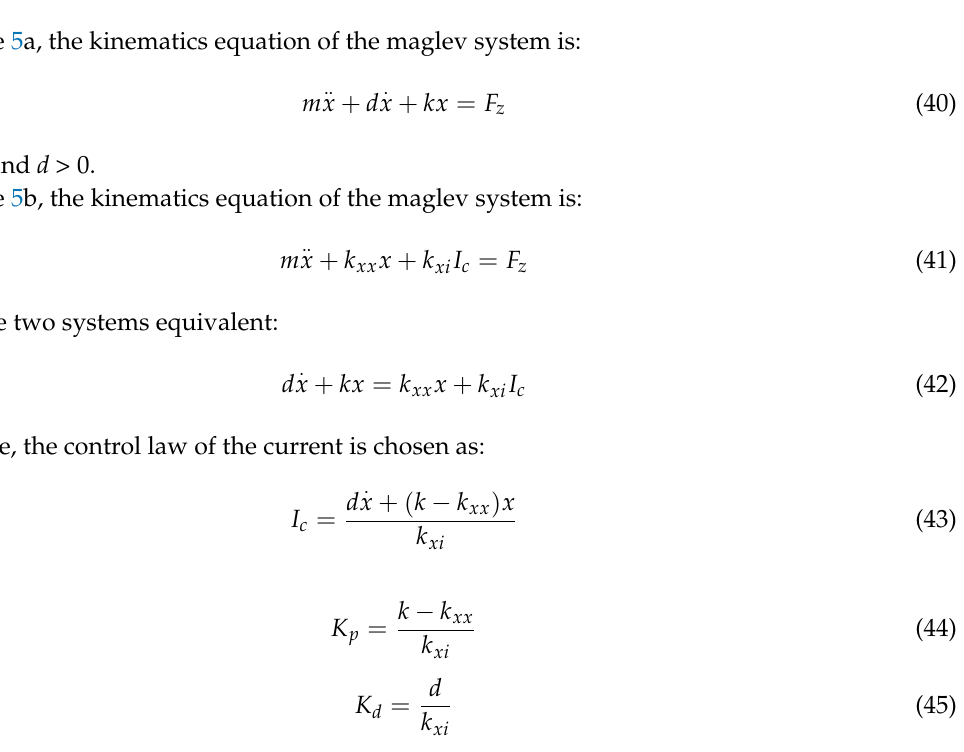
Figure 5. Comparison of the mechanical system and the maglev system. ( a )Mechanical system; ( b ) Maglev system.